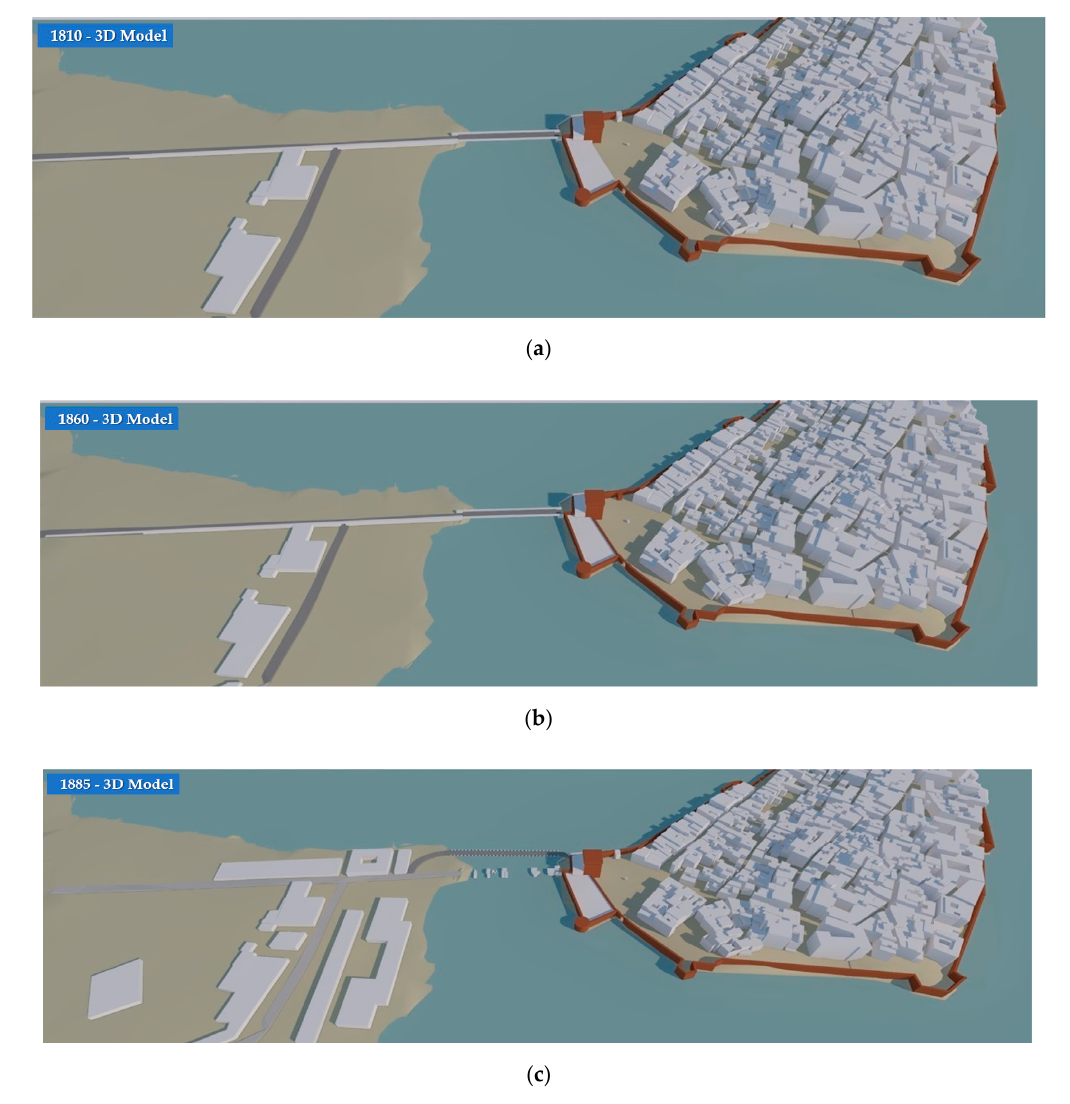
Figure 12. 3D models: ( a ) 1810, ( b ) 1860, ( c )